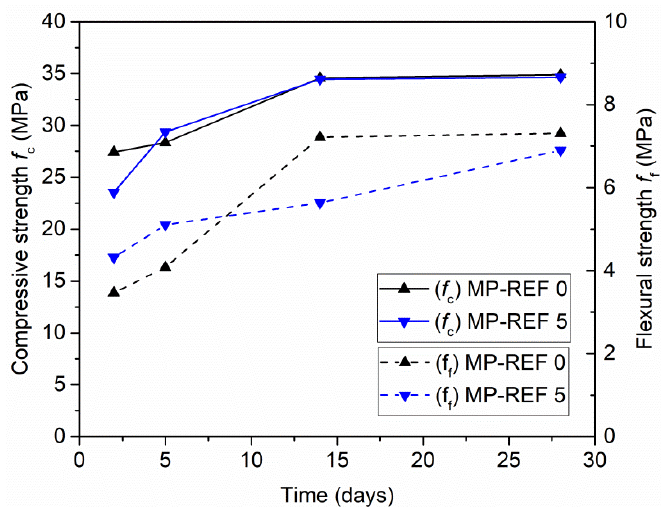
Figure 7. Strength development of reference mortars—age 2, 5, 14, and 28 days.